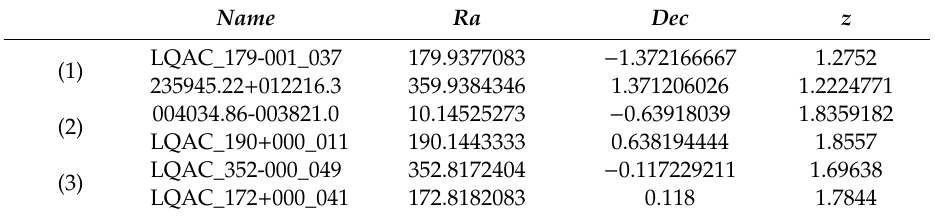
Table 16. Pairs of opposite quasars from the KQCG catalog [48] with the best accuracy in position and redshift for the cosmic mirror e ff ect. Accuracy is of 0.001 ◦ for ra and dec and 0.1 for z .